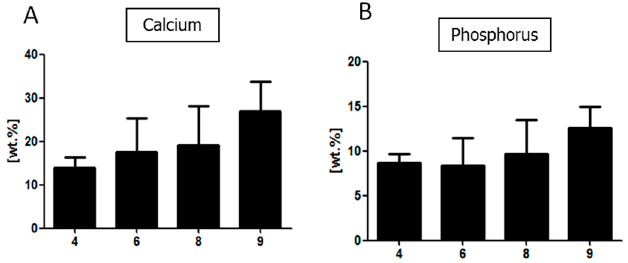
Figure 12. The results from SEM-EDX measurements of calcium and phosphorus concentrations deposited on each biomaterial during osteogenic differentiation (materials described in Table 3).